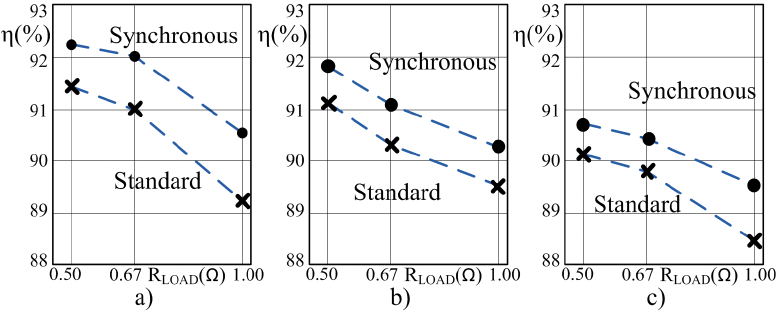
Figure 7. Graphical relationship of experimental efficiency measurements between standard and synchronous rectification switching schemes, as a function of load resistance. ( a ) V SC = 25 V. ( b ) V SC = 30 V. ( c ) V SC = 34